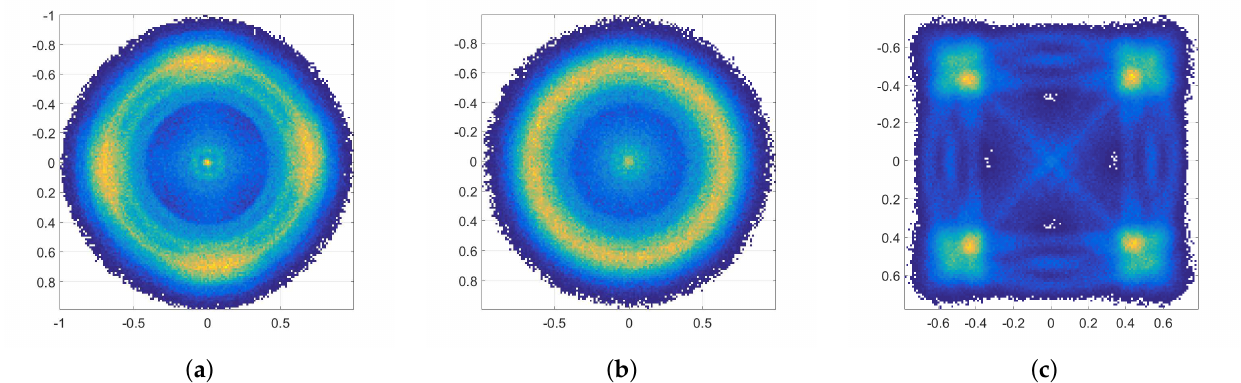
Figure 8. The signal constellation for EBEM signals suffers smearing due to varying amount of f d T , ( a , b ). Smearing is com- pletely reversed after phase offset correction. ( a ) Limited phase offset, ( b ) Phase offset of multiples of 2 π , ( c ) Constellation after phase and frequency offset correction.